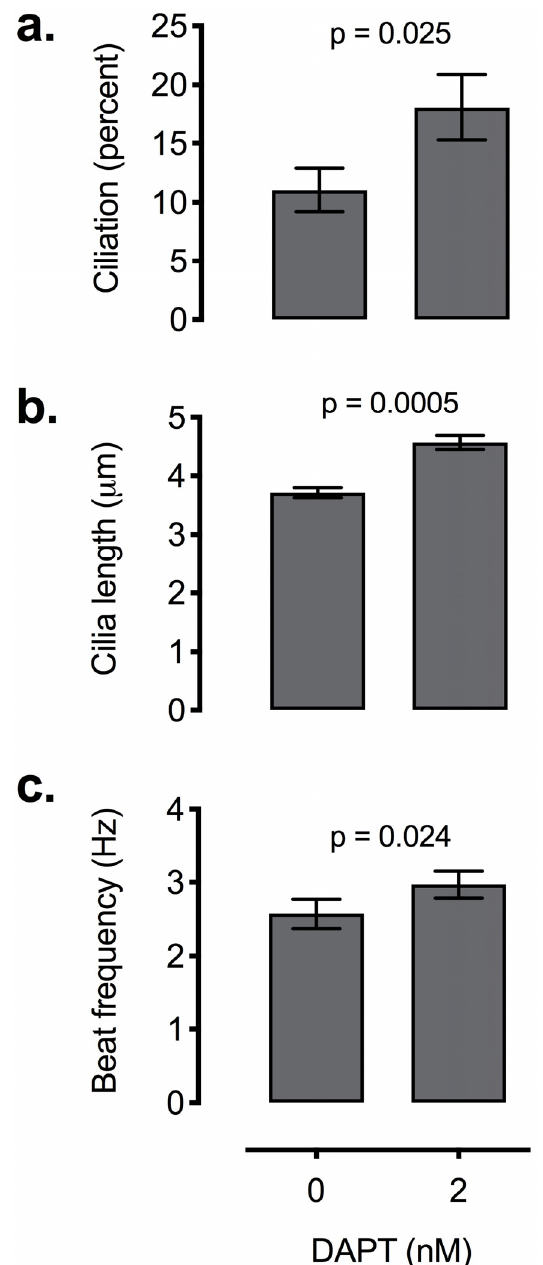
Figure 6. E ff ect of 2 nM of DAPT on ciliation of human nasal epithelial cells from 12 subjects. DAPT treatment led to significant increase in ciliogenesis ( a ), cilia length ( b ) as well as ciliary beat frequency ( c ). Error bars represent ± 1 SEM.